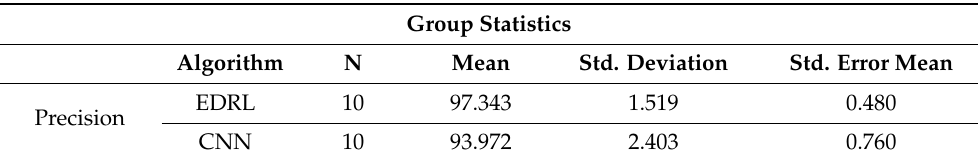
Table 7. Group statistics for precision comparison of EDRL vs. CNN algorithms to measure mean, standard deviation, and standard error mean.